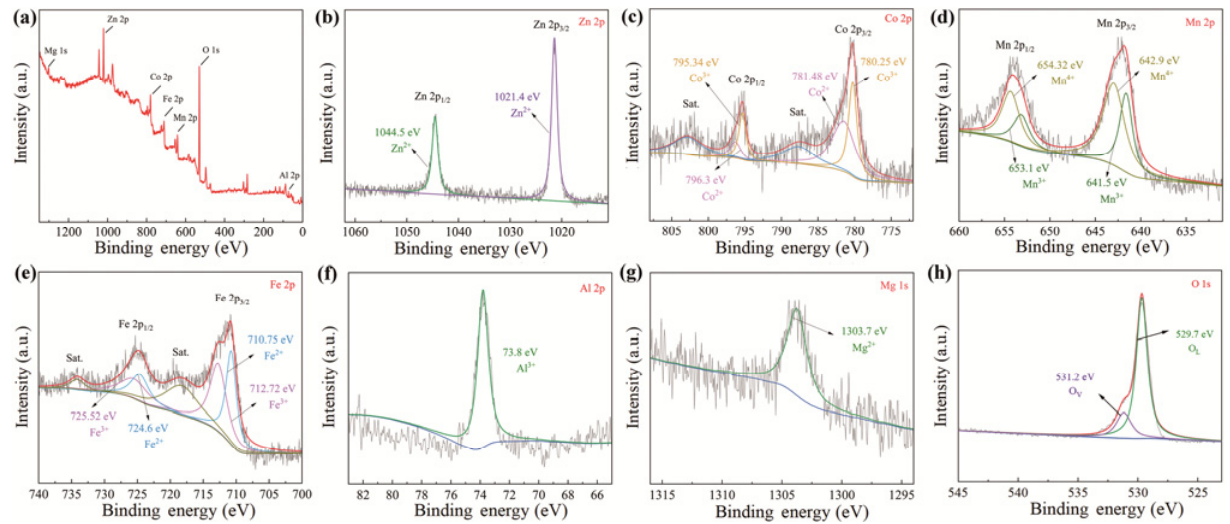
Fig. 5 XPS results of typical sample 6M-HEO-950: (a) survey spectrum and high-resolution spectra of (b) Zn 2p, (c) Co 2p, (d) Mn 2p, (e) Fe 2p, (f) Al 2p, (g) Mg 1s, and (h) O